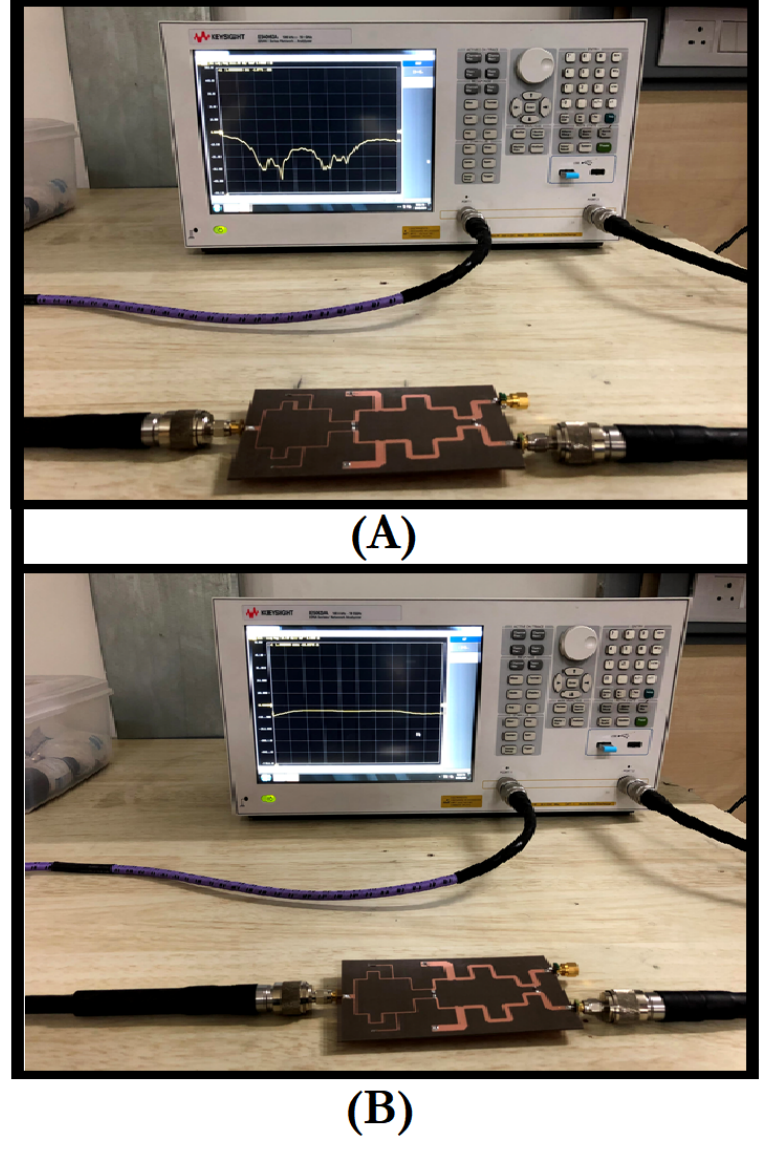
Figure 12. Measurement Setup for ( A ): S 11 ; ( B ): S 21 for θ c = 55 ◦ .